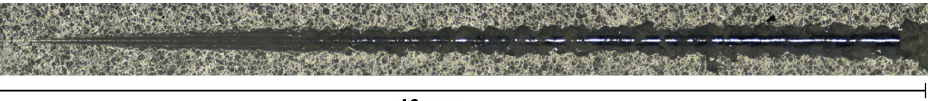
Figure 6. Optical microscope image of the scratched “black” protective coating (Olympus, objective, with 20× magnification, aperture of 0.4).